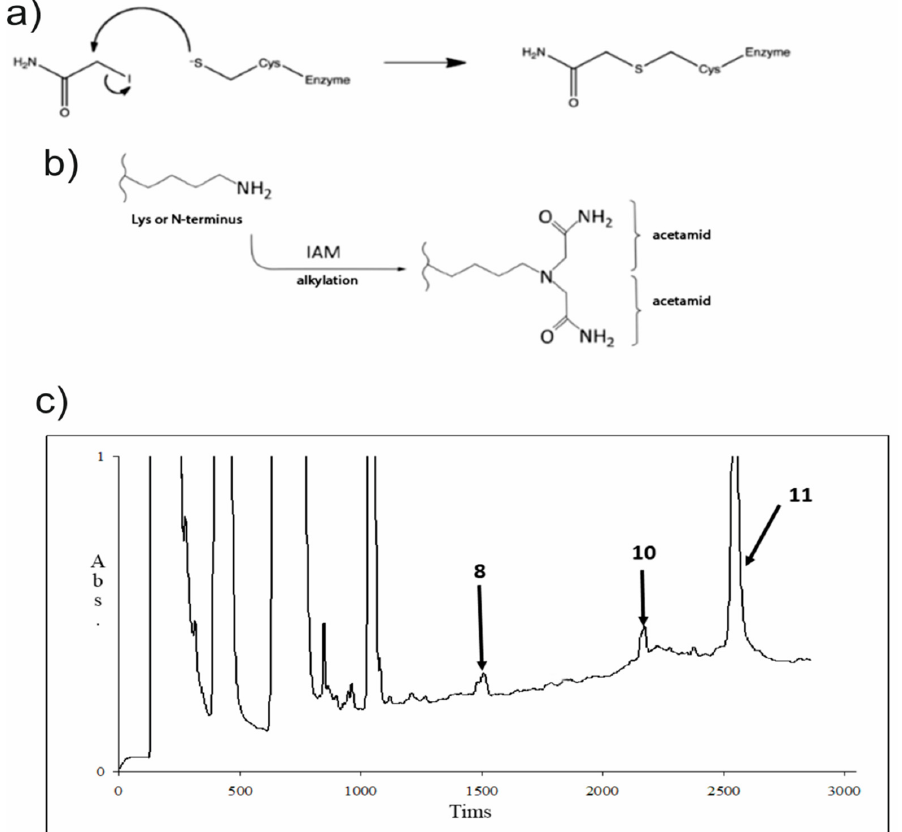
Figure 6. Protein modification and trypsinolisys results. ( a ) The chemical reaction of cysteine modification with IAA is presented. ( b ) The adverse reactions of the lysine side chain amino group and the N-terminus of the polypeptide modification with IAA are depicted. ( c ) An RP-HPLC chromatogram of the sample, performed after the trypsinolisys took place. The collected peaks are marked with corresponding numbers.